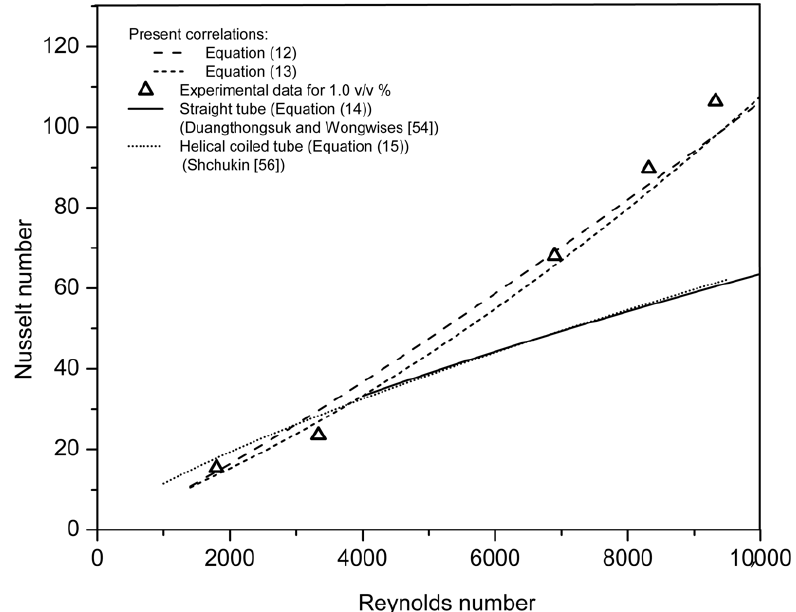
Figure 14. N Nu versus N Re of 1.0 v / v % TiO 2 –W NF in the coiled flow inverter (CFI) set, obtained in the present experiment (symbols) and predicted by the present correlations (Equation (12) shown using a dashed curve and Equation (13) shown using a short dashed curve), 1.0 v / v % TiO 2 –W NF tested by Duangthongsuk and Wongwises [54] in a straight tube (Equation (14) shown using a solid curve), and water in a helical coiled tube evaluated by Shchukin [56] (Equation (15) shown using a dotted curve).